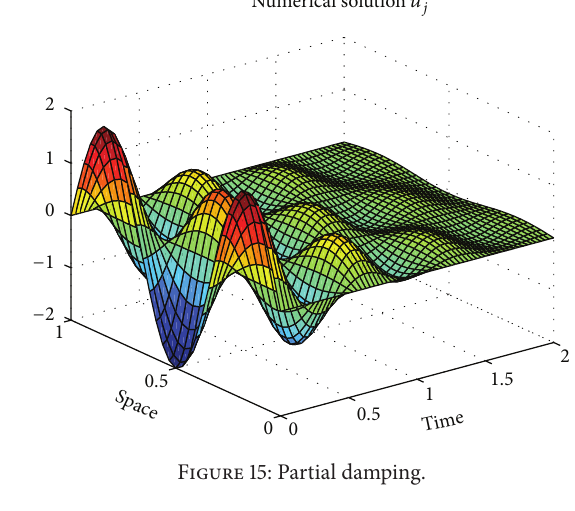
Figure 15: Partial damping.